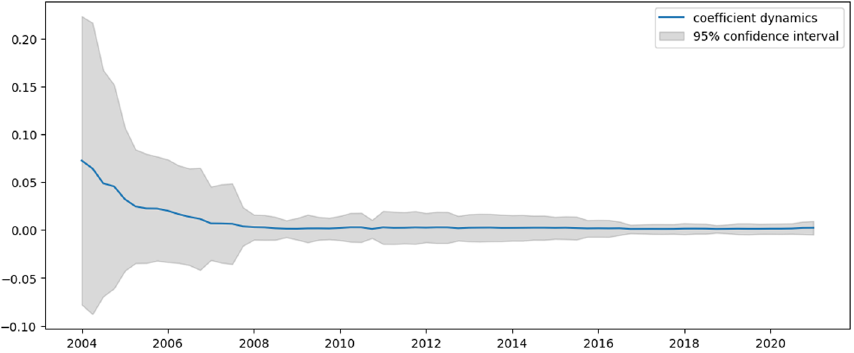
Fig. 7 Intercept dynamics for Amazon revenue